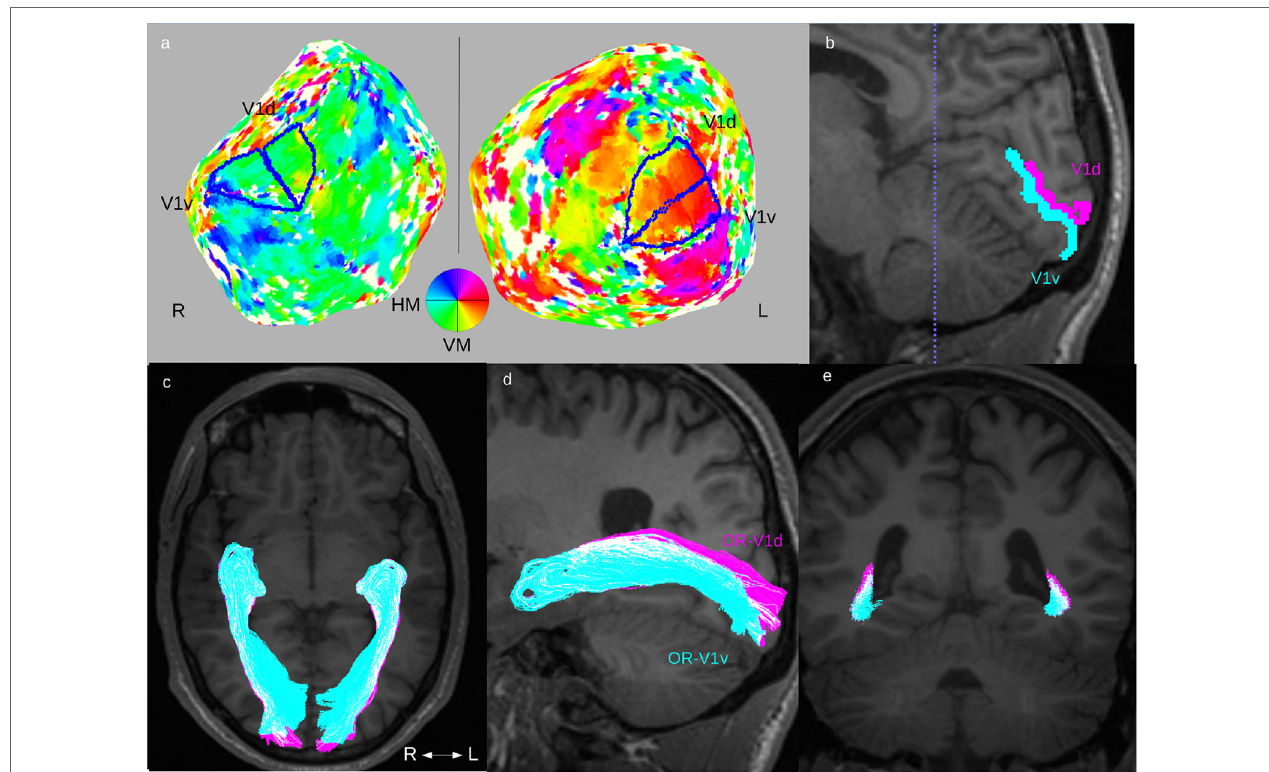
FigUre 1 | Fiber tractography of the optic radiation (OR). Overview of the complete fiber tracking procedure of the OR illustrated in one patient (Subject F). This patient had normal OR on fiber tractography and normal GCL_IPL thickness on OCT, and no visual field defects. Upper row: (a) definition of V1d- and V1v-ROIs from the retinotopic fMRI activation maps on cortical flattened 3D-T1w maps. (B) The left side’s V1d- (pink) and V1v-ROI (turquoise) mapped on a 3D-T1w image in sagittal midline section around the calcarine sulcus. Lower row: fiber tracts for OR-V1d (pink) and OR-V1v (turquoise) overlaid on 3D-T1w image in (c) an axial, (D) a parasagittal (only tracts on left side), and (e) a coronal section at the level of the trigone [dotted blue line in (B) ]. Note the spatial overlap between the OR-V1d and OR-V1v tracts along their course. Abbreviations: R, right; L, left; H/VM, horizontal/vertical